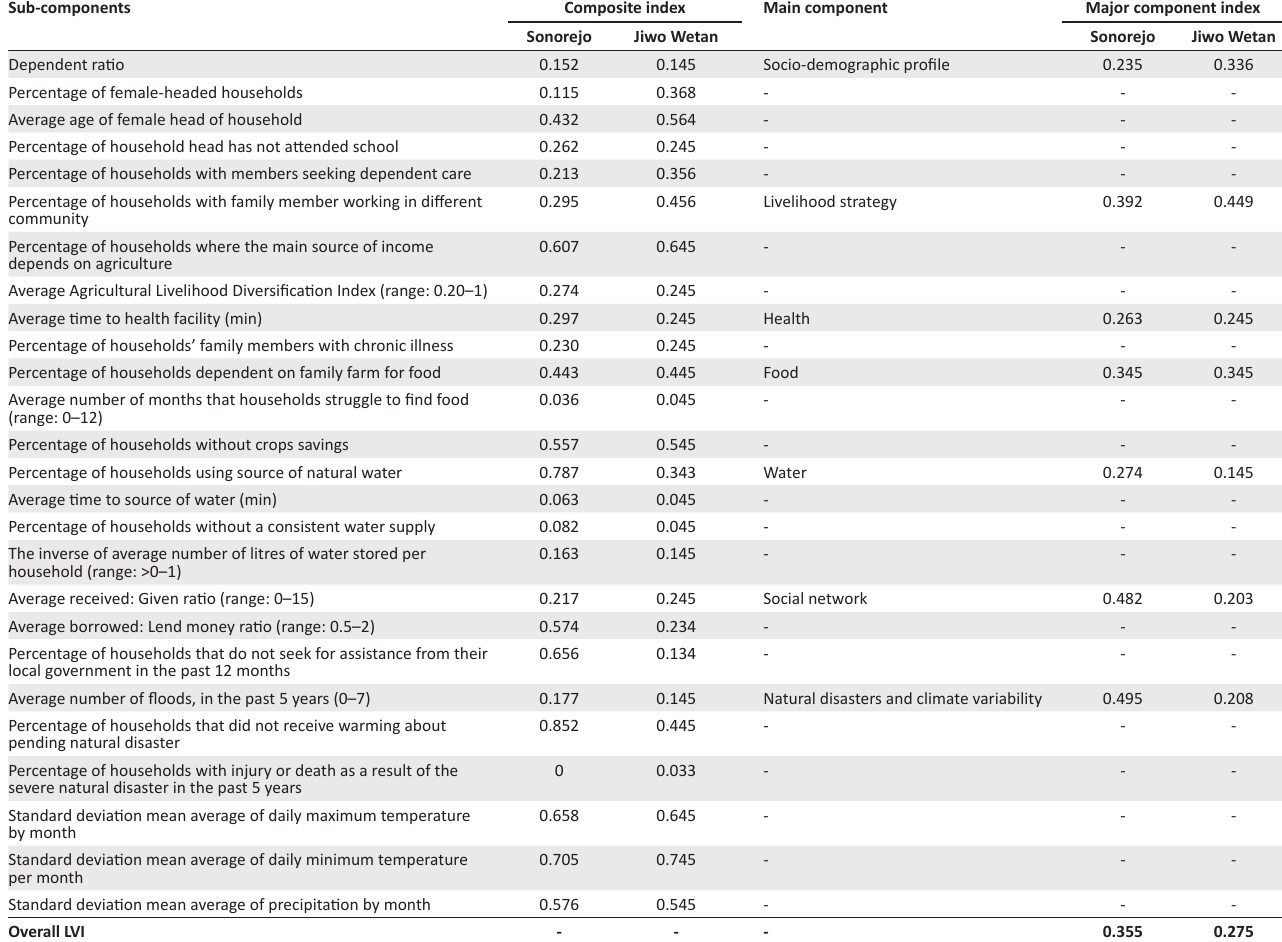
TABLE 4: Livelihood vulnerability index results for the Sonorejo and Jiwo Wetan villages.